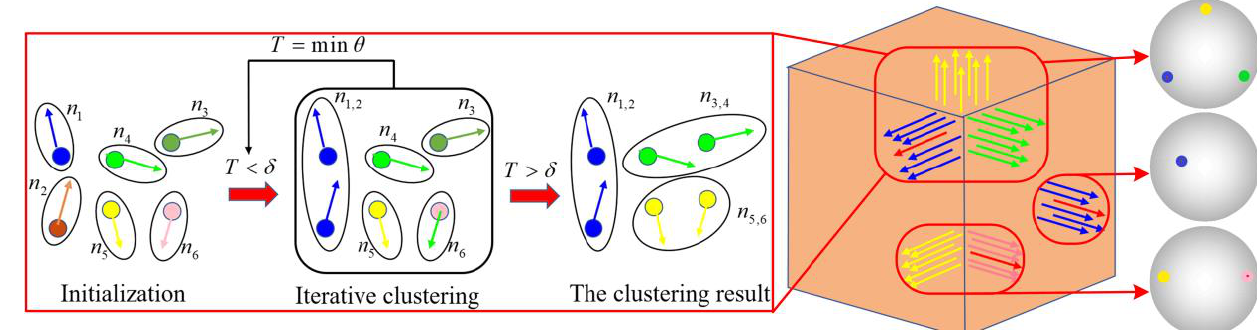
Figure 4. Gaussian map and clustering of cube.